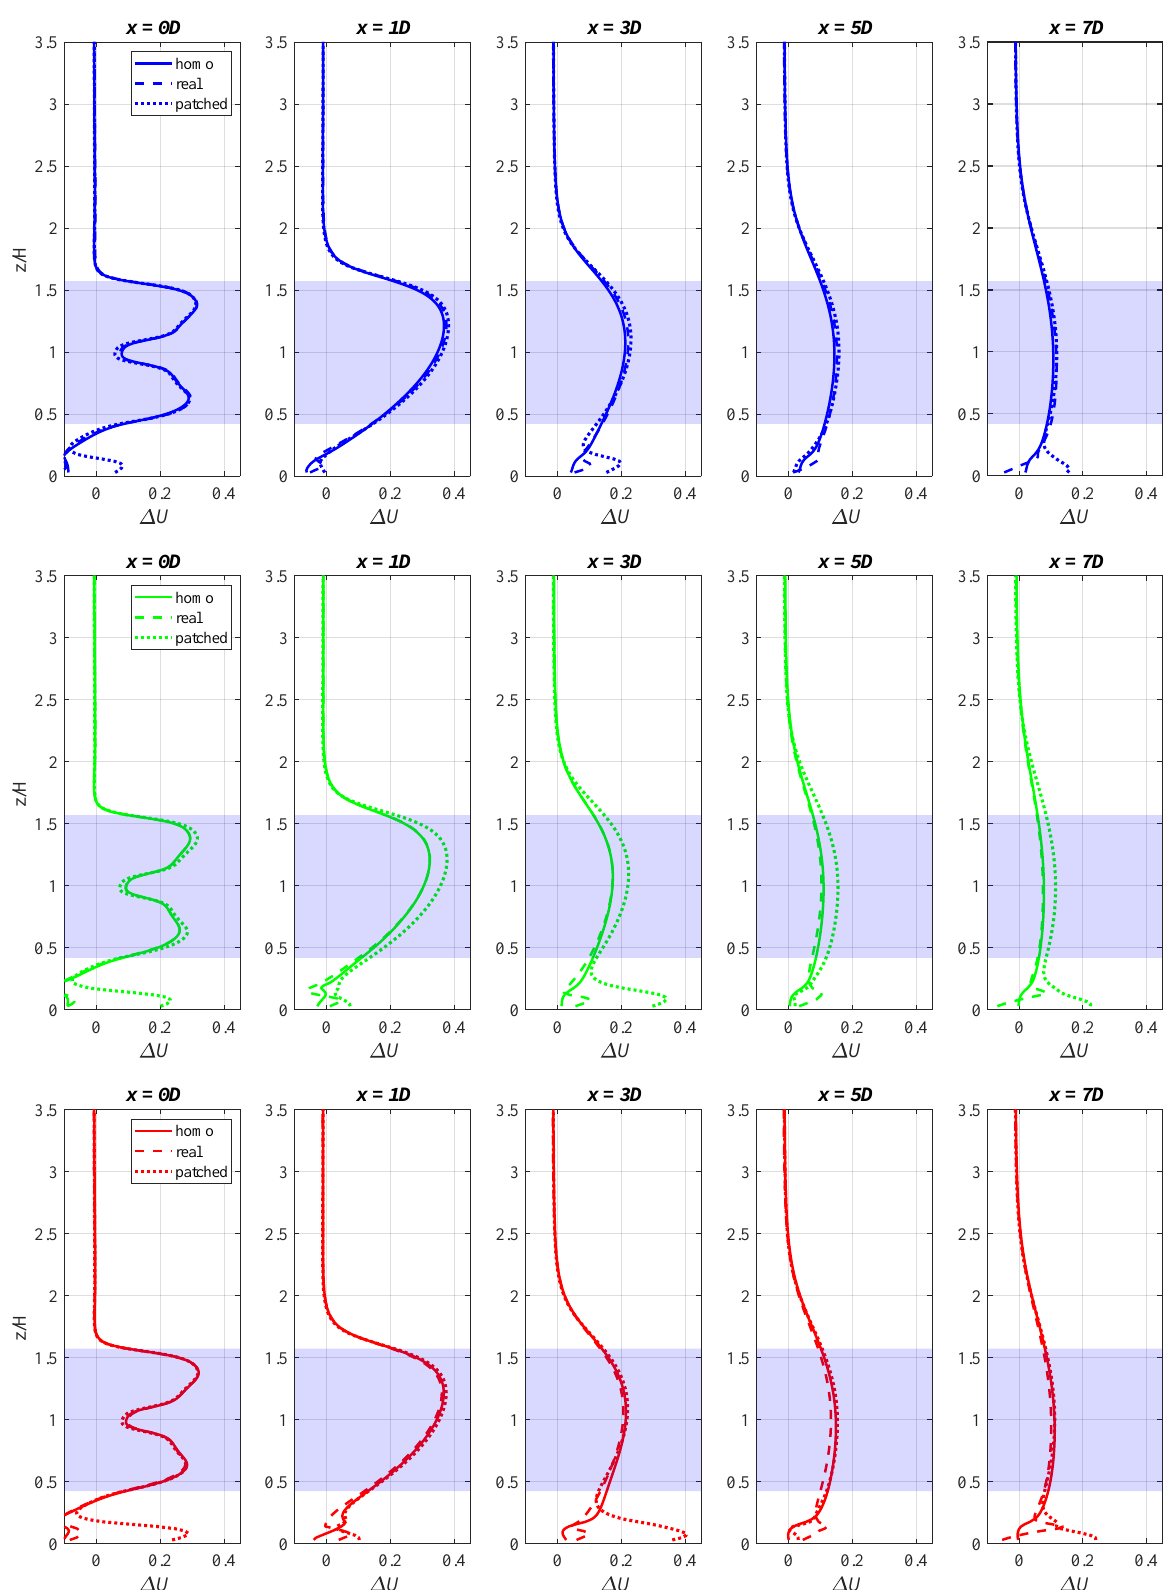
Figure 20. Vertical profiles of velocity deficits ( ∆ U) from the midplane for different densities with varying heterogeneity levels. Blue—LAI ≈ 0.43; green—LAI ≈ 1.7; red—LAI ≈ 4.3. The purple shaded region is the turbine rotor